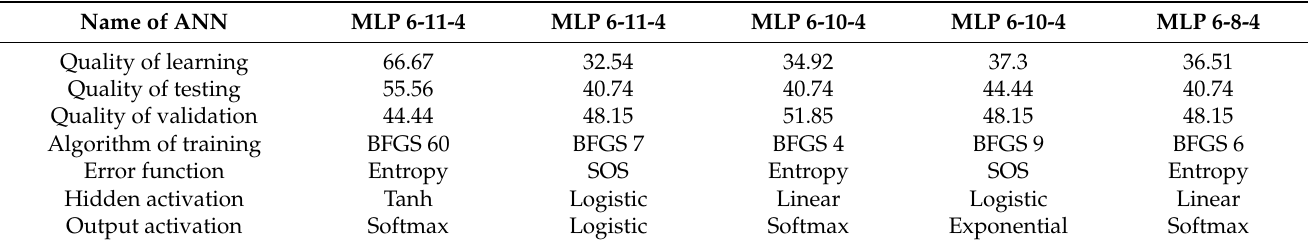
Table 2. Results of learning artificial neural networks created in Statistica 13.3, together with the parameters of the best models created for the four-class classification on the basis of the